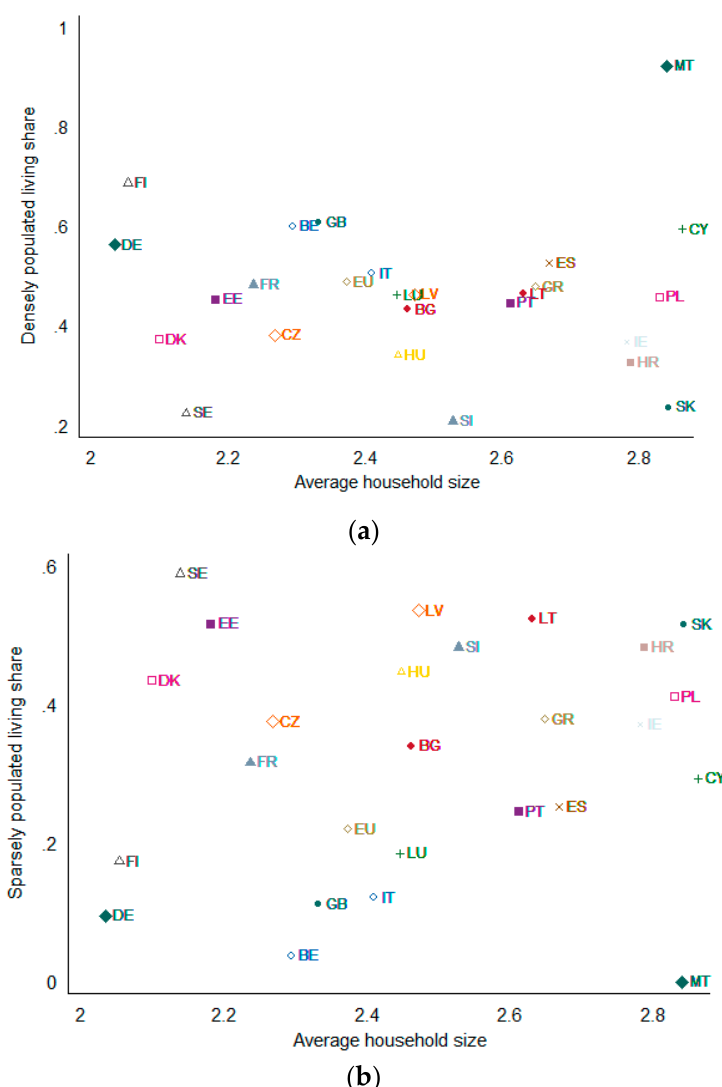
Figure 4. Association between average household size and share of households living in densely ( a ) and sparsely ( b ) populated areas in the EU. In cases where the shares do not add up to one, the difference amounts to the share of households living in intermediately populated areas. Household weights provided by the HBS have been applied.